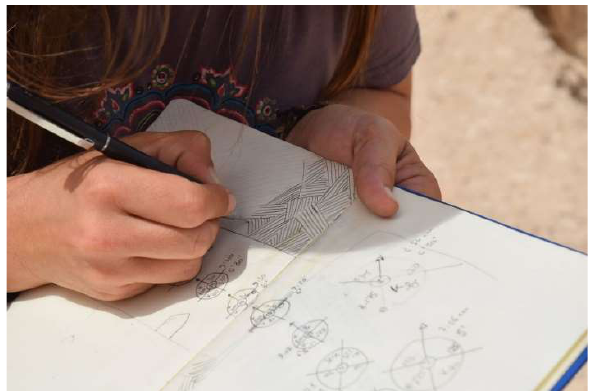
Figure 6. Different positions of 3D scanner